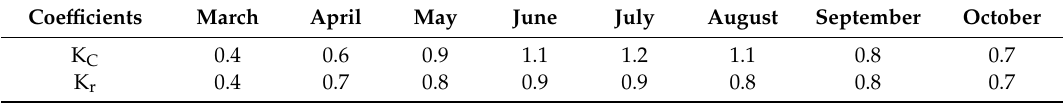
Table 1. Local crop reduction and crop coe ffi cient values used in the